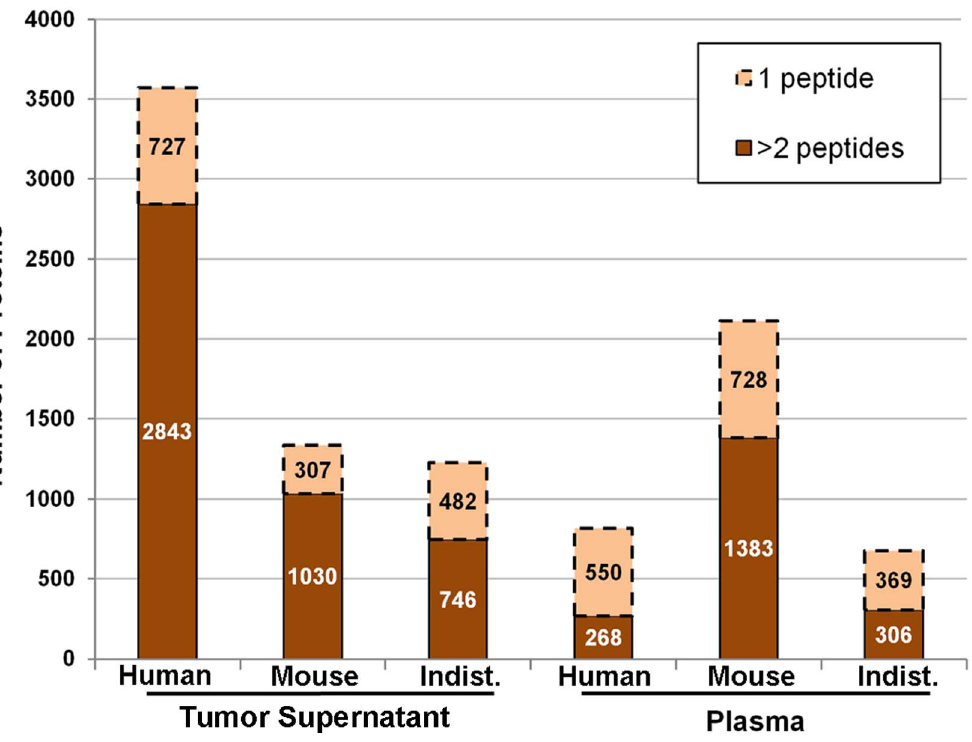
Figure 2. Proteins identified in the xenograft plasma and tumor supernatant. The numbers of unique (nonredundant) proteins identified in the OVCAR-3 xenograft tumor supernatant and mouse plasma are shown after sorting proteins based on species classification where at least one peptide was uniquely human, uniquely mouse, or indistinguishable (Indist.), that is, all detected peptides were common to human and mouse